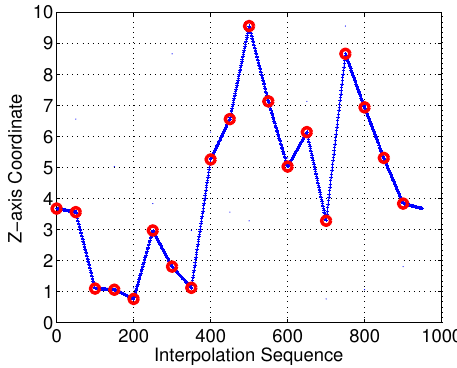
Figure 22. Z -axis of linear-interpolation three-dimensional (3D) Dubins curves (case